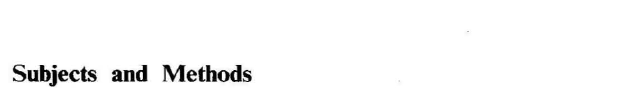
Table 3. Analysis of neopterin (N), biopterin (B), and